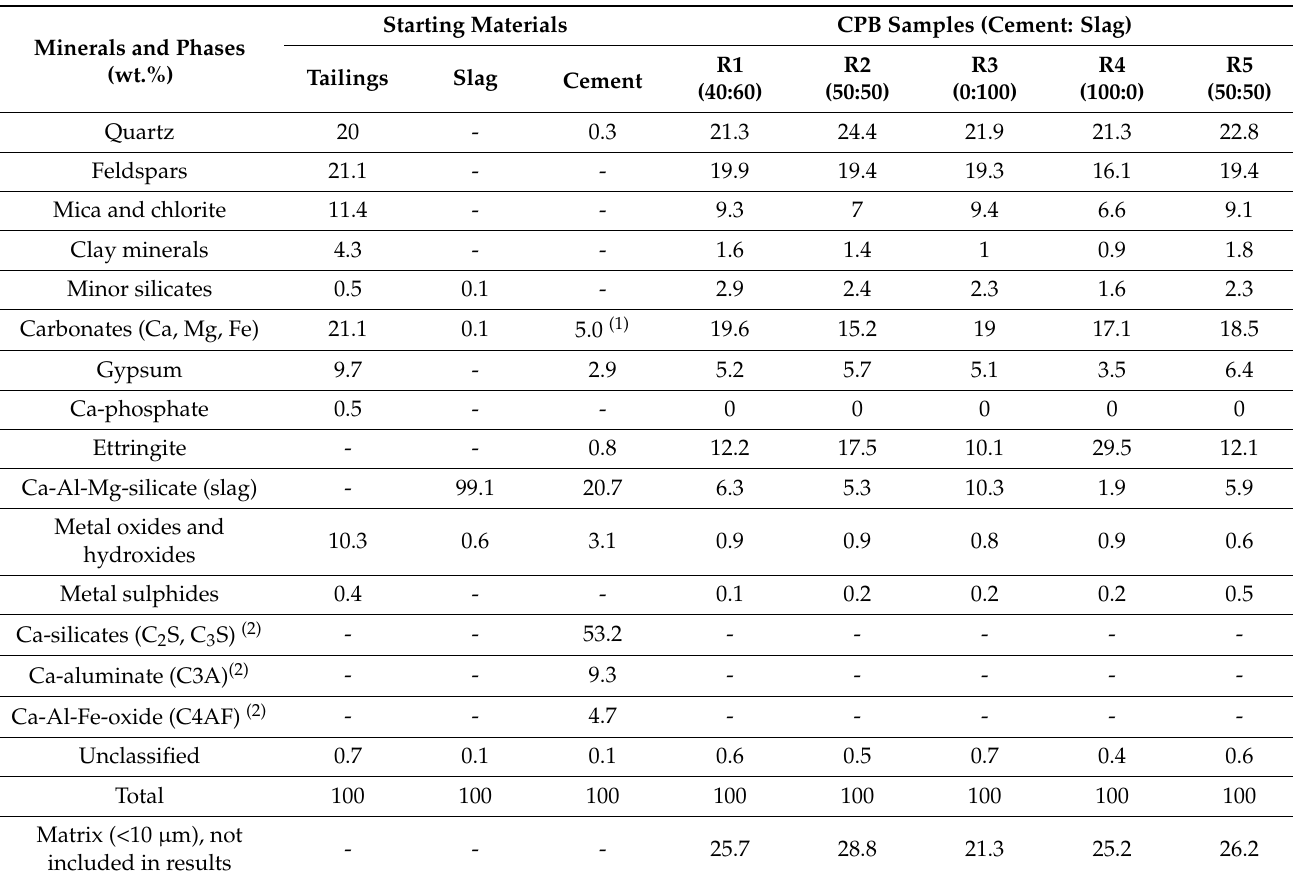
Table 6. Measured mineral and phase compositions of tailings, slag, cement, and CPB specimens (R1–R5). Cement to slag ratios used in CPB preparation are given along with the specimen codes. “–” = not